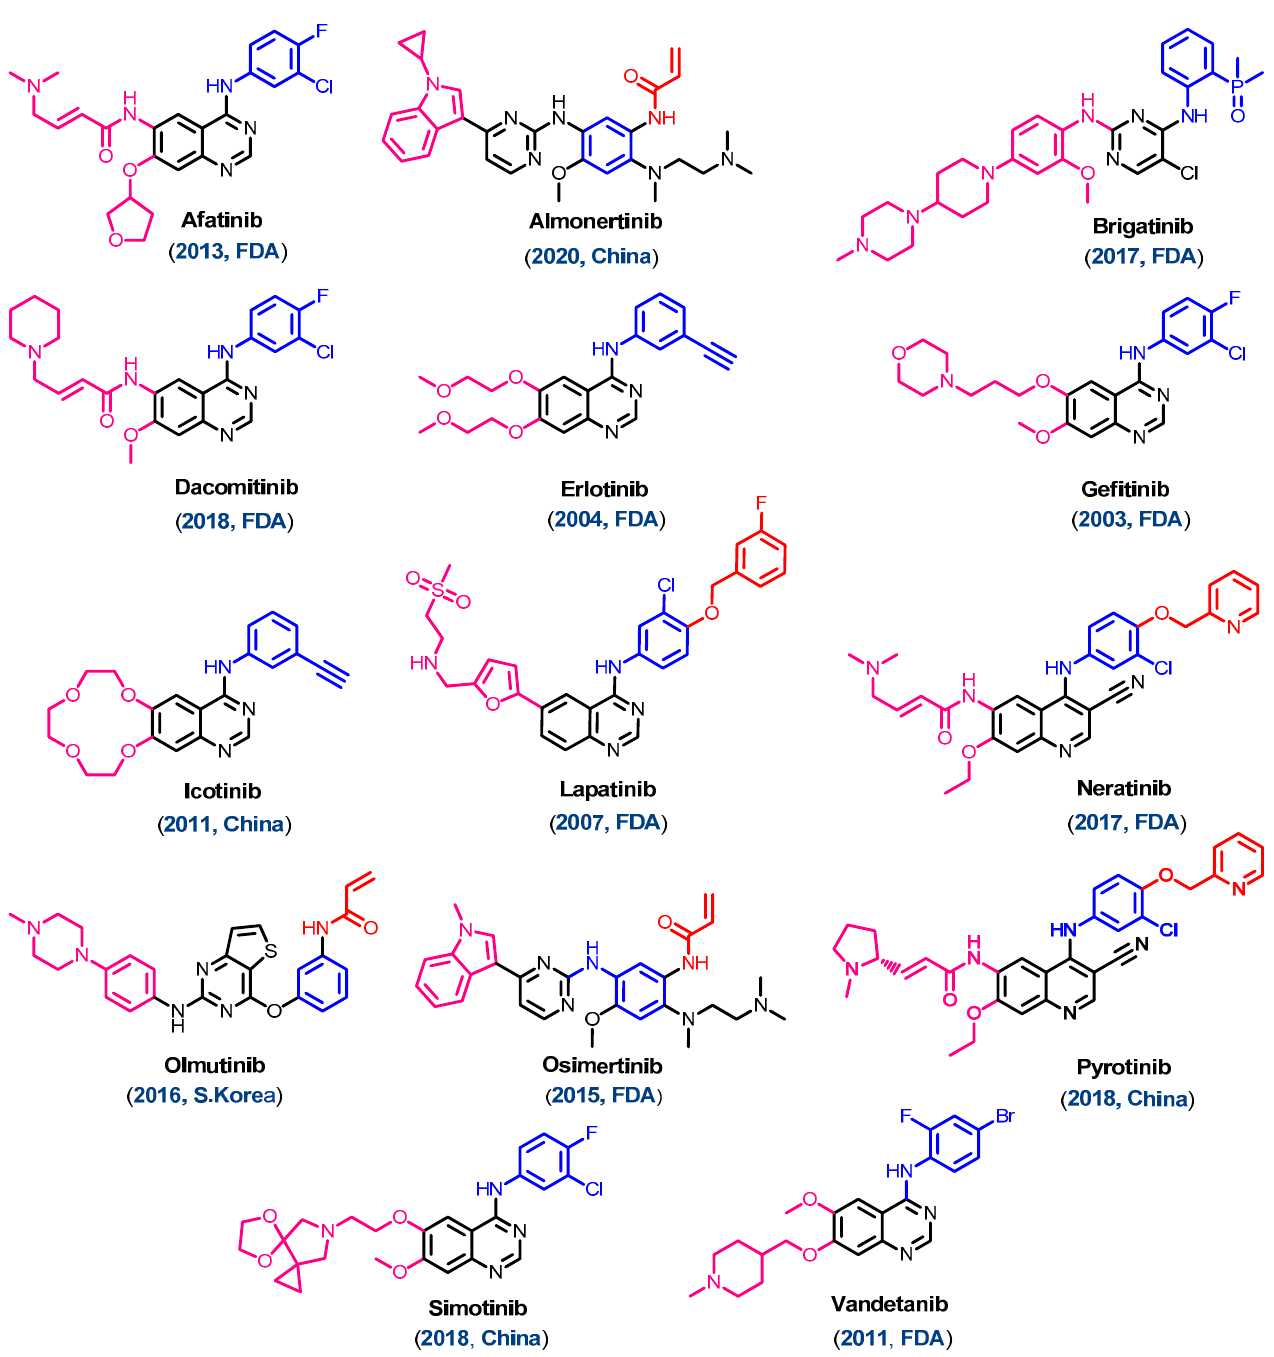
Figure 3. Chemical structure of the approved EGFR inhibitors.